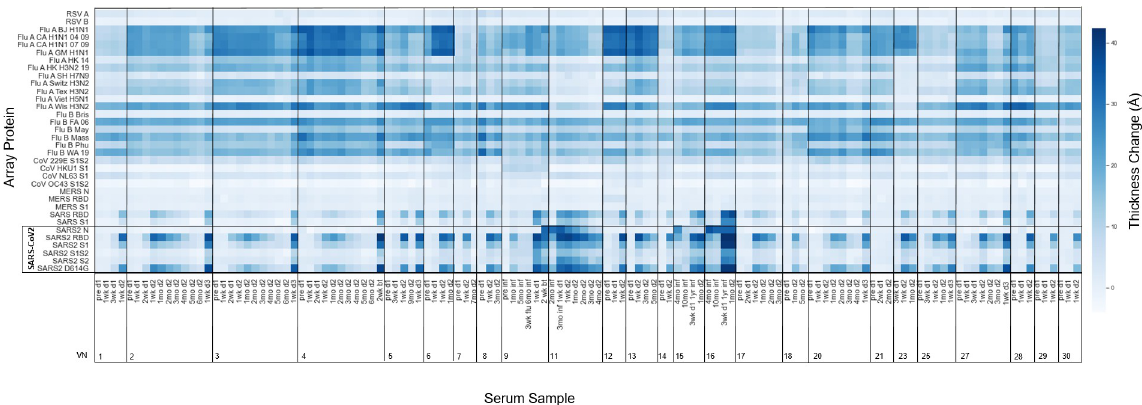
Fig 4. Thickness change per array protein in vaccinated subjects. Thickness change is representative of antibodies binding to antigens on the 34-plex array for longitudinal serum samples collected from vaccinated subjects.